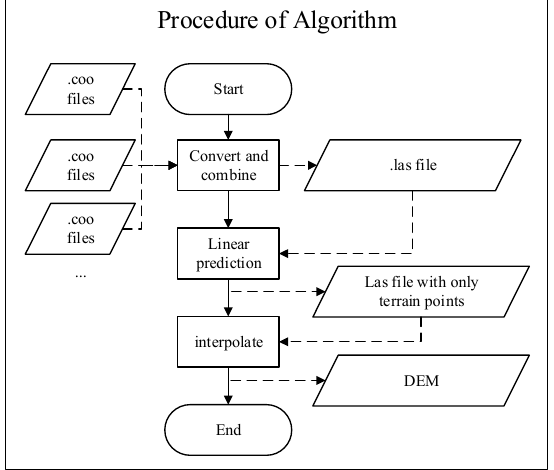
Figure 3. Procedure of